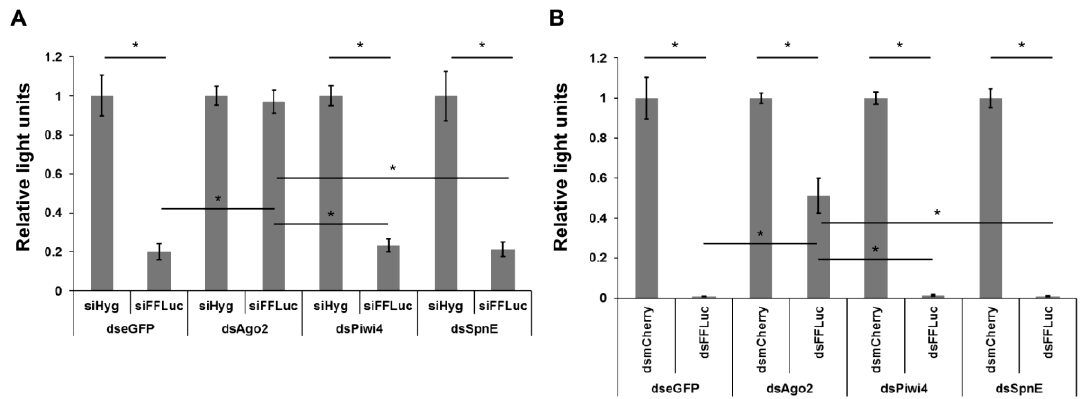
Figure 4. Effect of SpnE knock down on the siRNA pathway based silencing efficiency. Aag2 cells were first treated with dsRNA against eGFP (control), Ago2, Piwi4 or SpnE. 24 h later the cells were co-transfected with FFLuc and Rluc expressing reporter plasmids (pIZ-Fluc and pAcIE1-Rluc) and siRNAs against FFLuc (siFFLuc) or Hygromycin B (siHyg) ( A ) to assess the silencing ability of pre-formed siRNAs in the cells, or alternatively dsRNAs targeting FFLuc (dsFFLuc) or mCherry (dsmCherry) ( B ) to assess the silencing ability of siRNAs produced in a Dcr2-dependent manner. Cells were lysed at 24 hpt and activities of luciferases determined. Relative luciferase levels are shown on the Y-axis (with FFLuc/Rluc ratio in siHyg or dsmCherry transfected cells set to 1). The mean values with standard error are shown for three independent experiment conducted in triplicate, * shows p < 0.05 using two-way ANOVA.